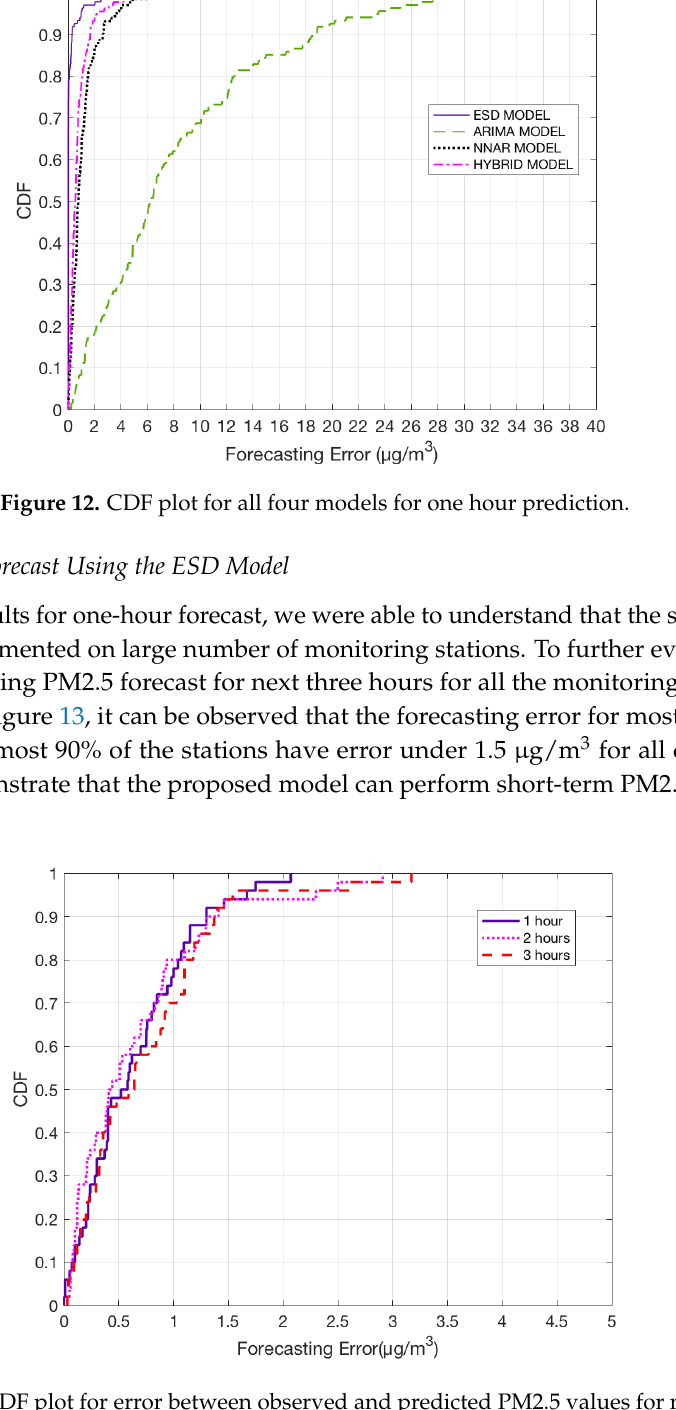
Figure 13. CDF plot for error between observed and predicted PM2.5 values for next 3